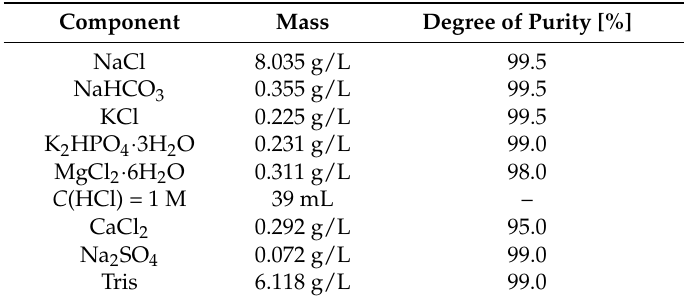
Table 1. Composition of the simulated body fluid (SBF).